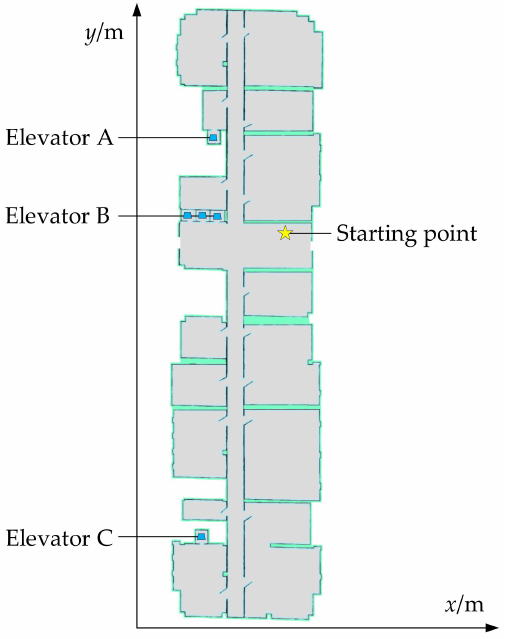
Figure 10. Schematic diagram of starting point